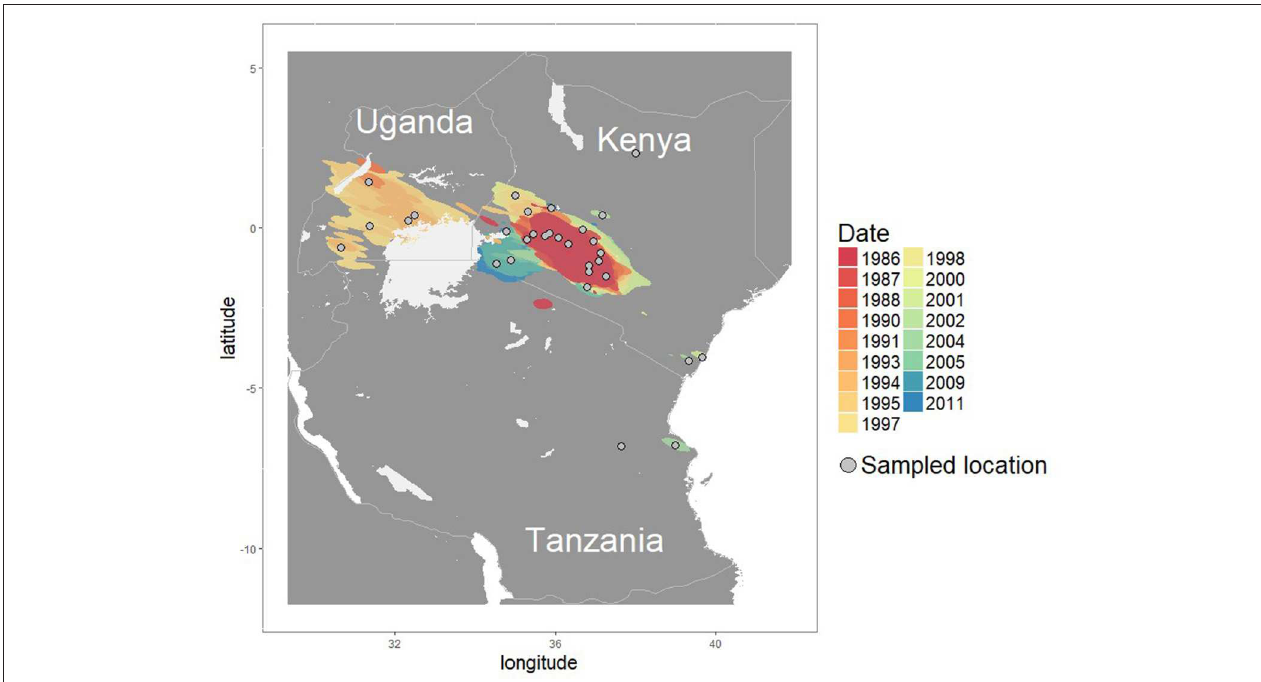
FIGURE 4 | Map showing the continuous diffusion of the isolated clade of FMDV serotype O, with the sampled locations as gray circles. The virus movments were reconstructed using a random walk model with a underlying lognormal